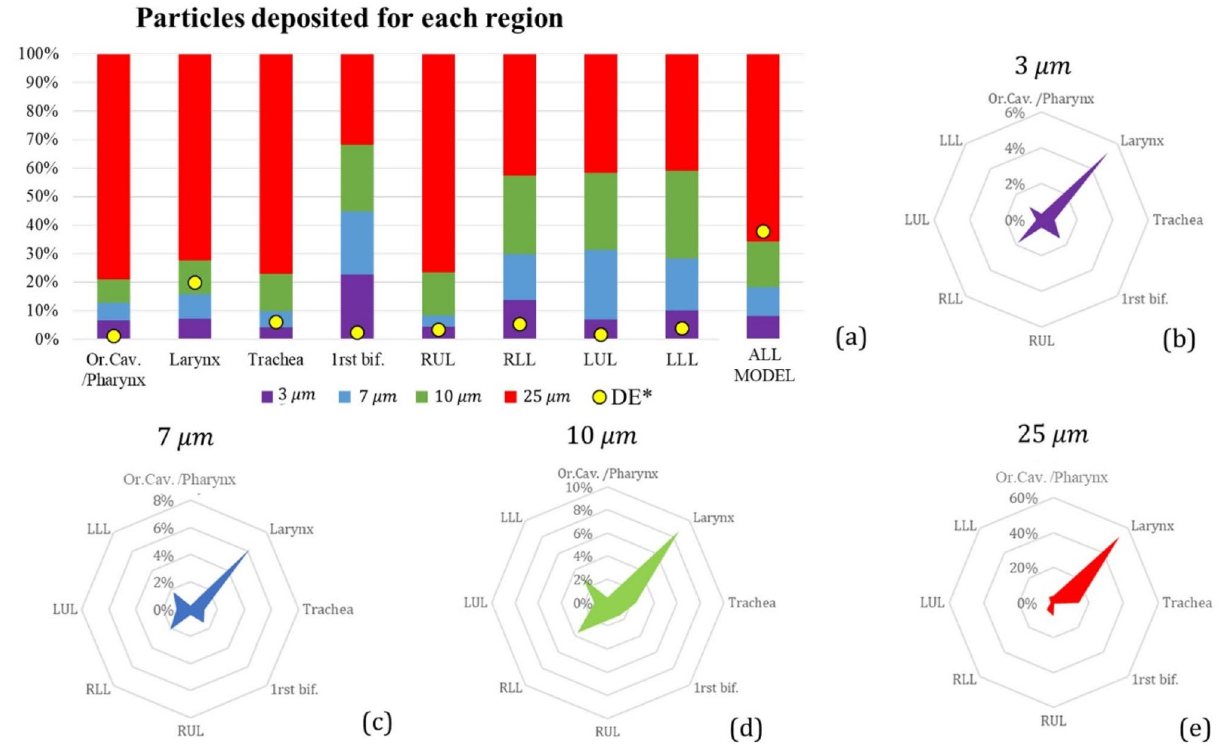
Figure 4. ( a ) Size distribution of particles (3–7–10–25 µm), as fraction of deposited particles in each region under steady conditions (Q = 6 L/min). DE* is total deposition efficiency for each region and for all models. RUL and RLL are the right upper and lower lobes, LUL and LLL are the left upper and lower ones. RML have been included in RLL. ( b – e ) DE made explicit for each simulated size in every region.